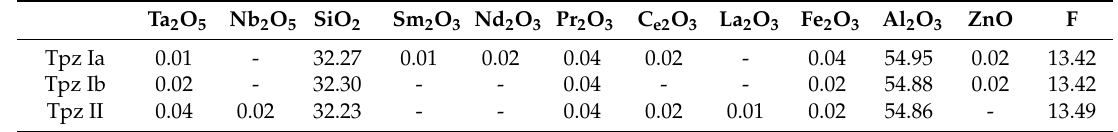
Table 3. Elemental median concentration values (wt %) characterizing each topaz